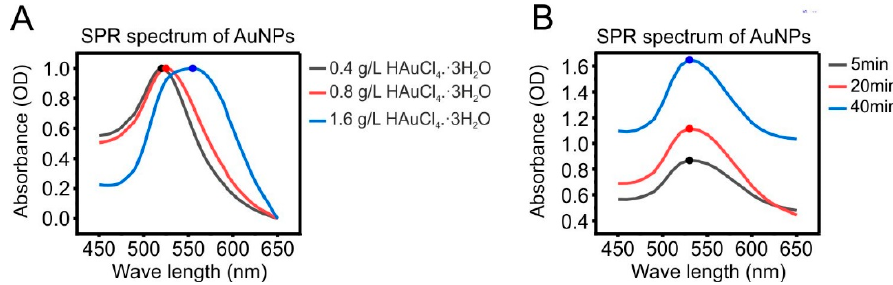
Figure 1. UV-visible absorption spectrum of gold colloids AuNPs prepared with ( A ) different concentrations of HAuCl 4 ·3H 2 O, in which increasing the concentration of the gold chloride leads to a lambda max shift from 520 nm to 550 nm, or ( B ) different boiling duration with fixed concentration of HAuCl 4 ·3H 2 O, in which the λ max of the different samples was constant at about 530 nm but their λ max absorbance increased according to the increase of the boiling duration.